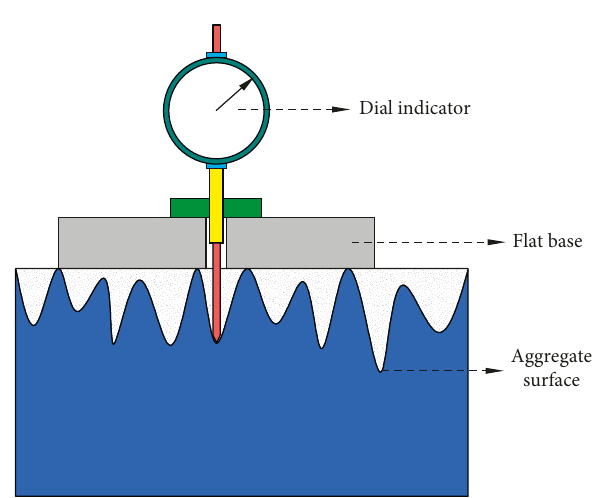
Figure 4: Measurement principle of interface